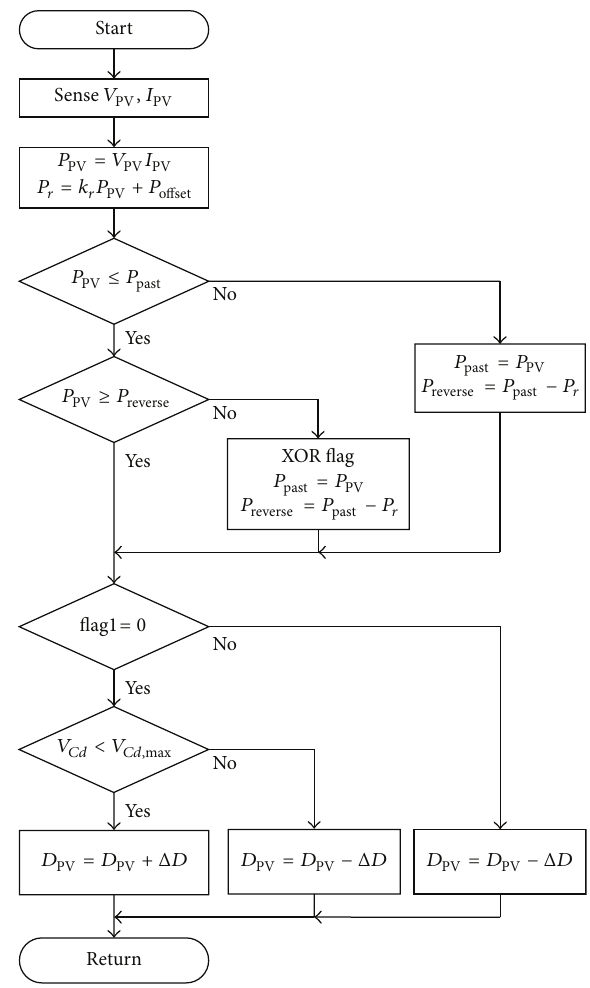
Figure 3: Flowchart of adopted MPPT